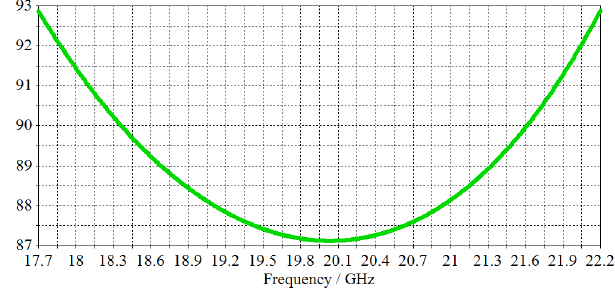
FIGURE 6. Differential phase shift (°) introduced by optimized guide polarizer